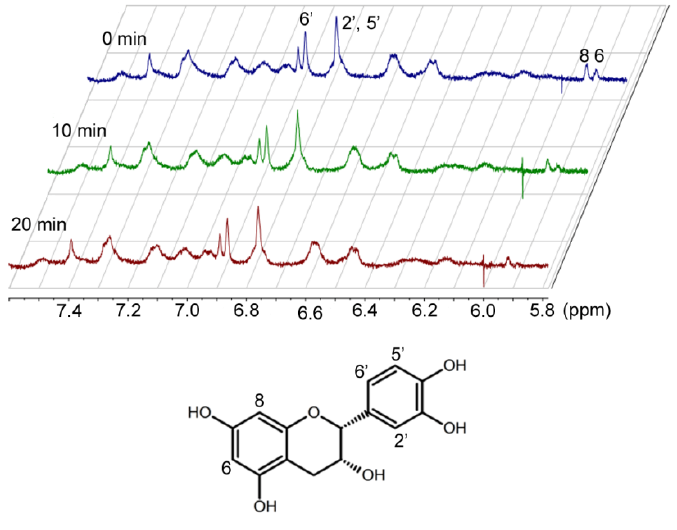
Figure 4. Proton NMR spectra of epicatechin and cytochrome c over